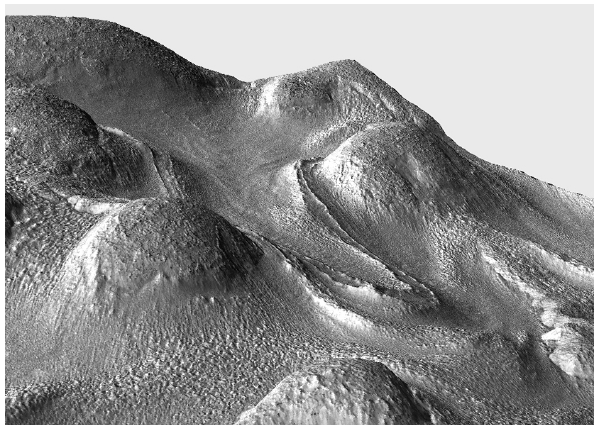
Figure 1. A 3-D image of a typical martian GLF (#948 in the in- ventory of Souness et al., 2012), which is ∼ 4km long and ∼ 600m in altitudinal range. The GLF shows evidence, through deformed chevron-like surface ridges, of down-slope flow; is longer than it is wide; and is bounded on all sides. This well-studied GLF is also bounded by a series of well-defined moraine-like ridges. Image re- produced after Hubbard et al. (2011). Table 1. List of commonly used terms and corresponding acronym.